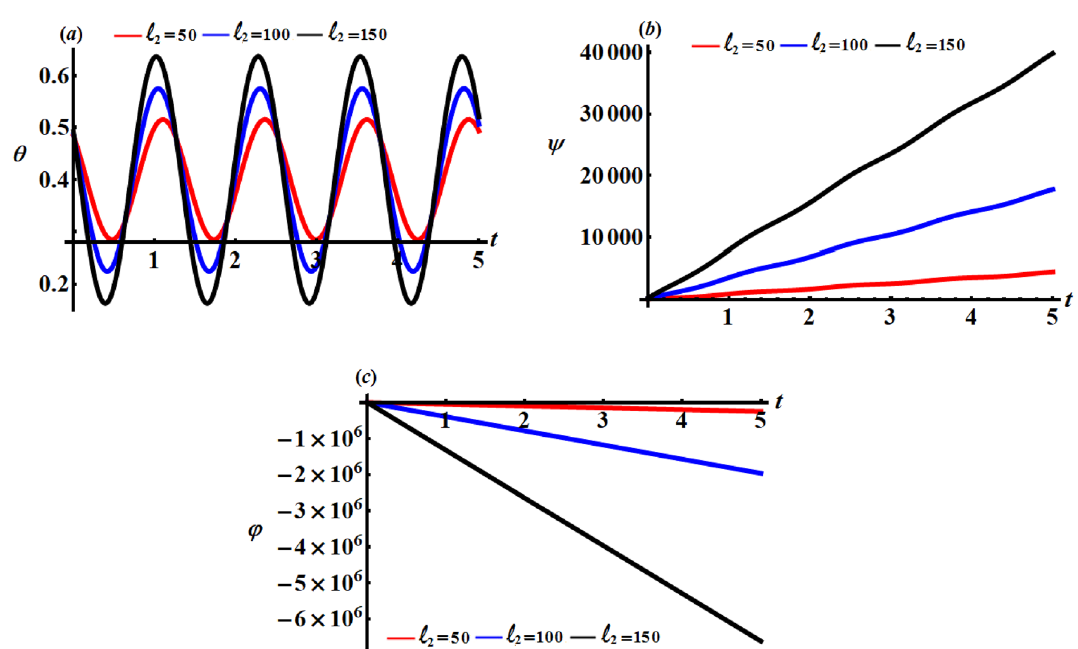
50, 100, 150 ) kg m 2 s − 1 . =